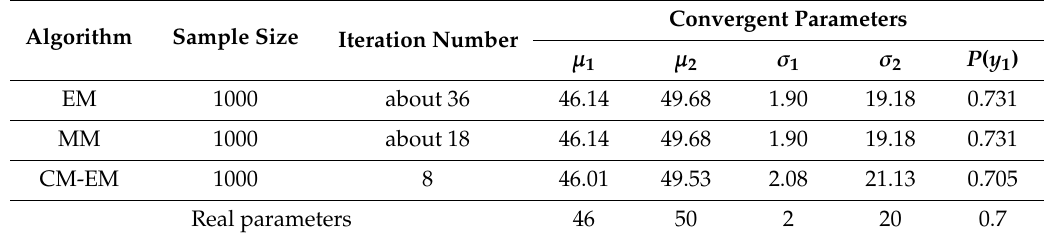
Table 5. The iteration numbers and final parameters for di ff erent